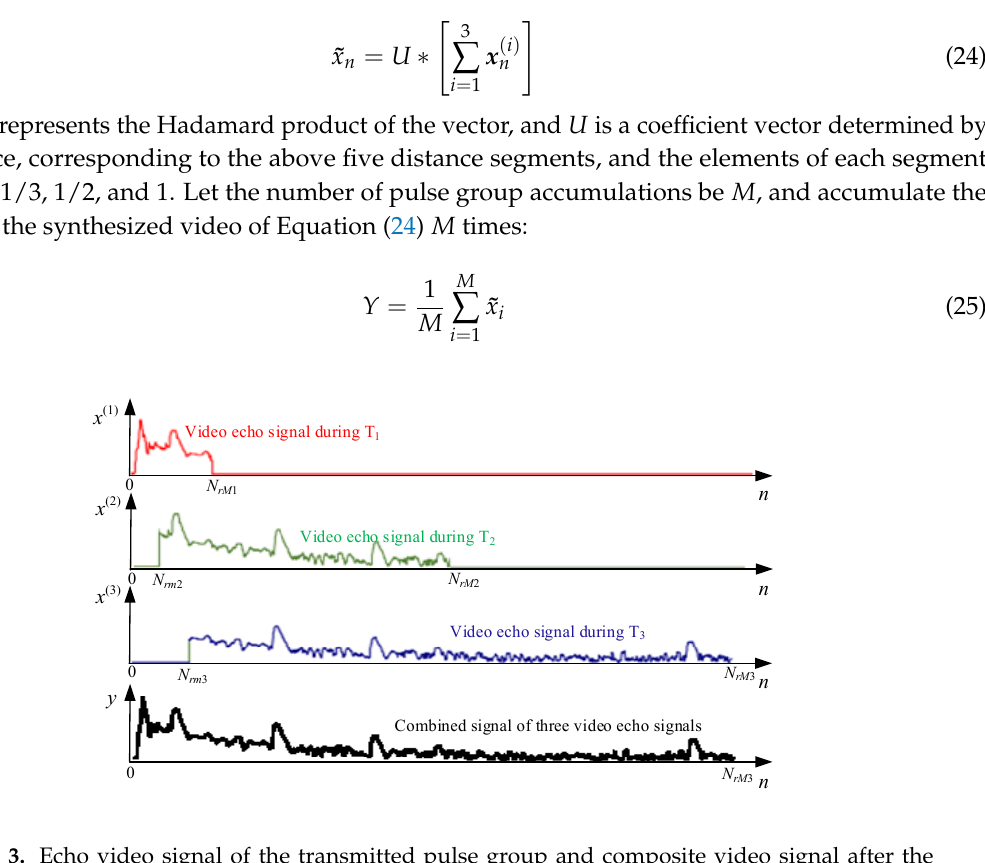
Figure 3. Echo video signal of the transmitted pulse group and composite video signal after the distance